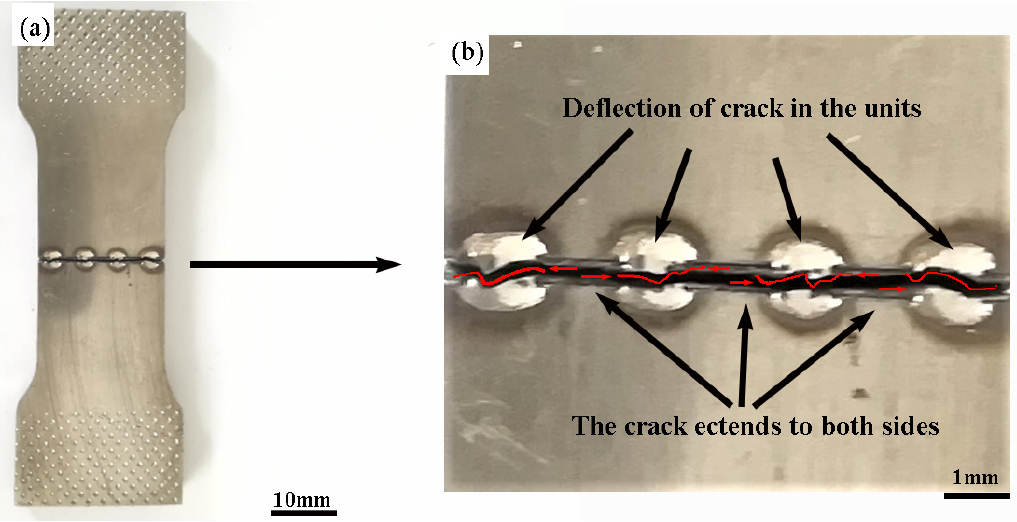
Figure 13. The fracture morphology of units. ( a ) Tensile specimen after fracture; ( b ) partial magnification of the tensile fracture.